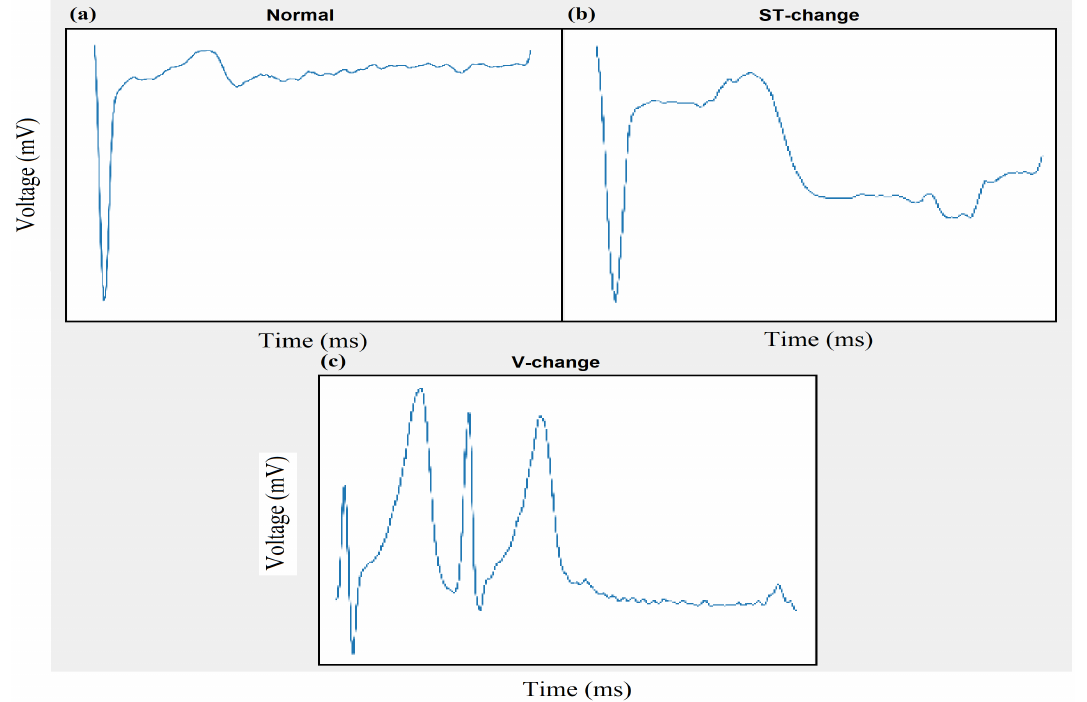
Figure 11. Experiment 3 Intra-patient scheme using DS3.1: Classification of Normal ( a ), ST-Change ( b ), and V-change ( c ) beats using 2-D CNN.